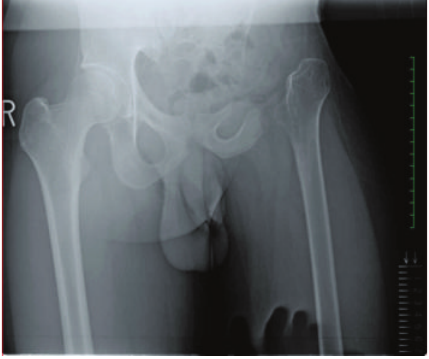
Figure 1: Radiograph of the hip joints at first visit.